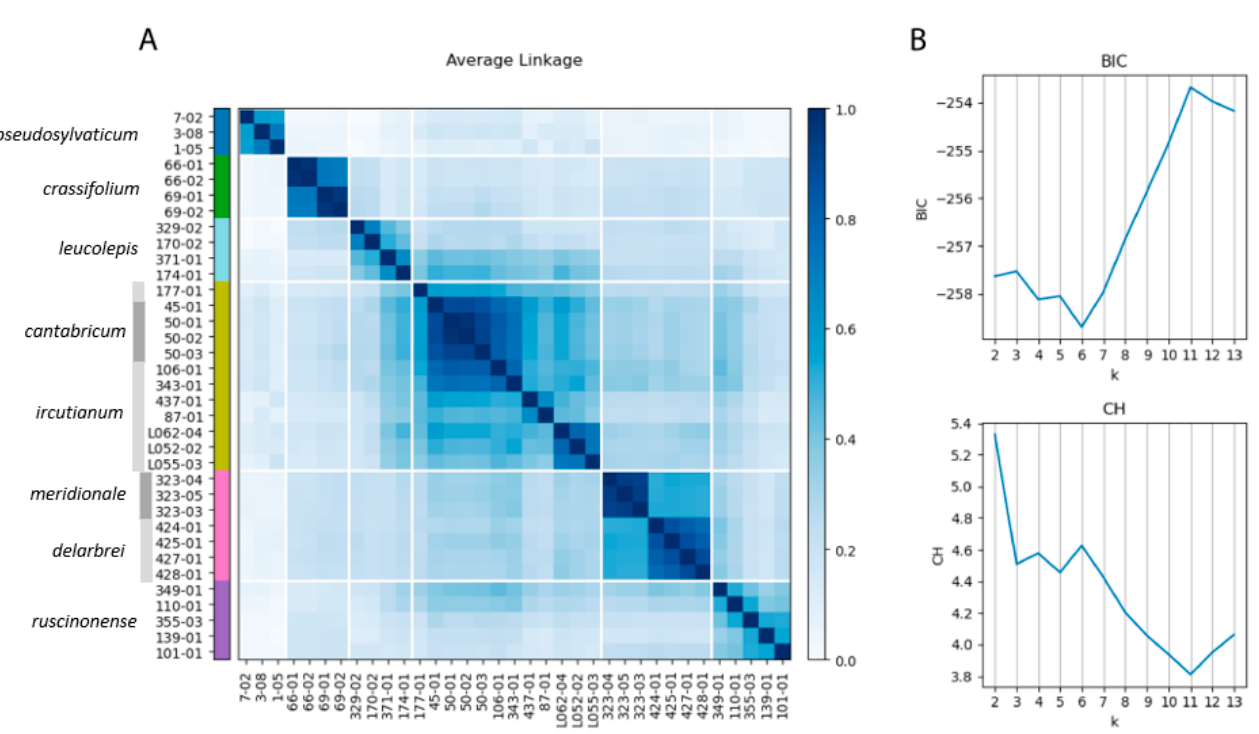
Figure 3. ( A ) Co-association matrix for the tetraploid Leucanthemum taxa based on weighted ensemble of random (k)k -Means (WKM) clustering and SNP-based Nei distances. Consensus clusters for k = 6 are shown, with colour bars depicting consensus cluster membership. ( B ) BIC and CH metrics for number of clusters ranging from k = 2 to k = 13.